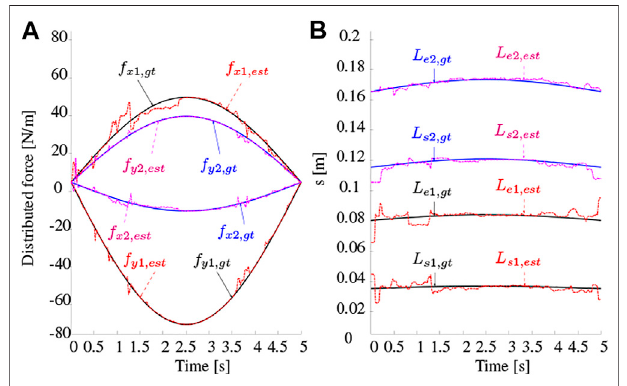
FIGURE 6 | UKF simulation with two distributed forces applied onto a rod. The magnitudes and locations are varying sinusoidally over time ( gt (cid:2) ground truth, est (cid:2) estimated).